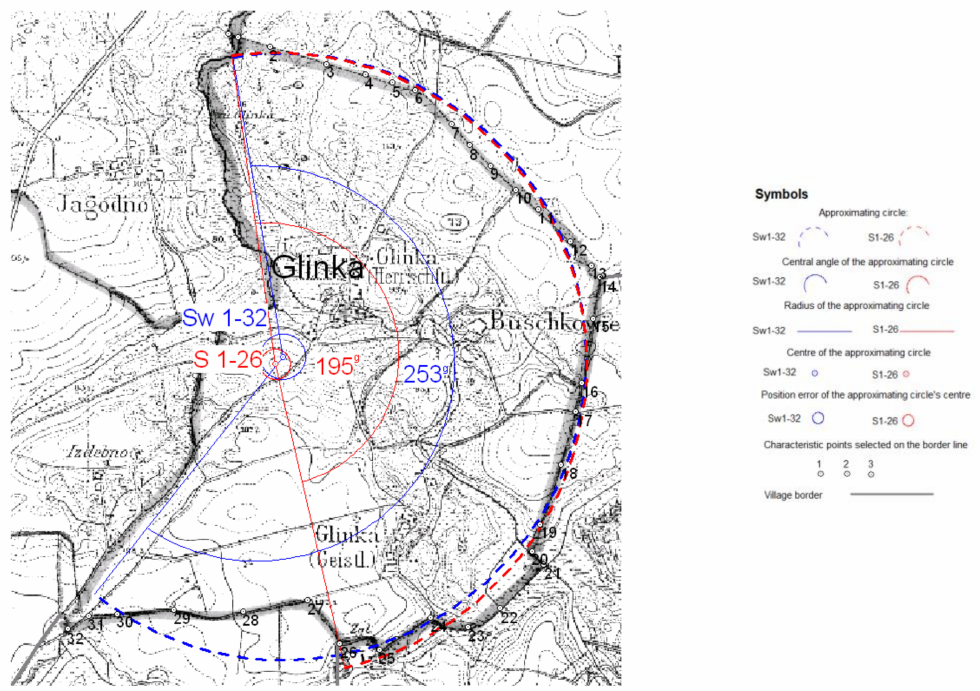
Figure 9. Glinka. Course, position and error of the approximating circle: Sw 1—32—approximation of points 1—32; S 1—26—approximation of points 1—26. Scale